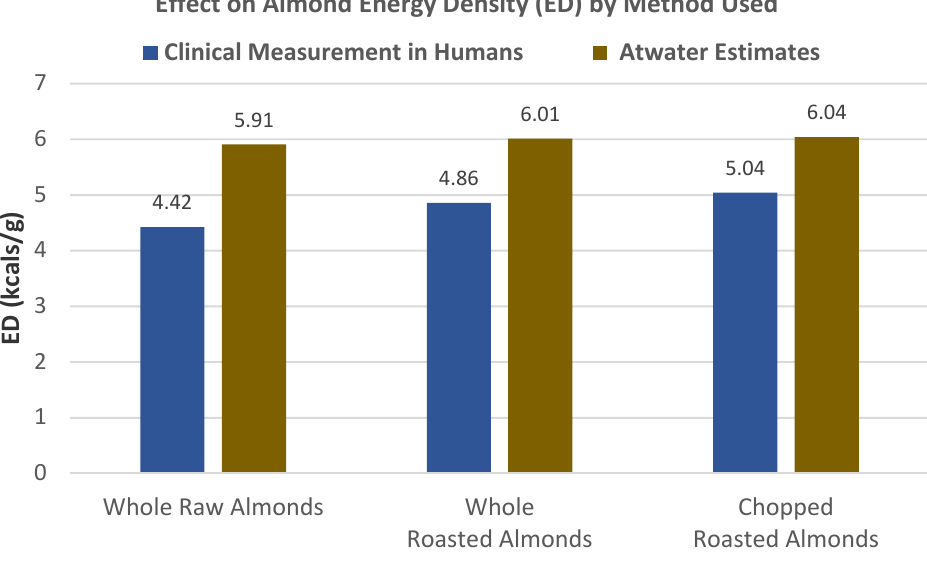
Figure 7. Differences in ED between Atwater estimates and direct clinical measures of three forms of almonds when added to the typical American diet [6].